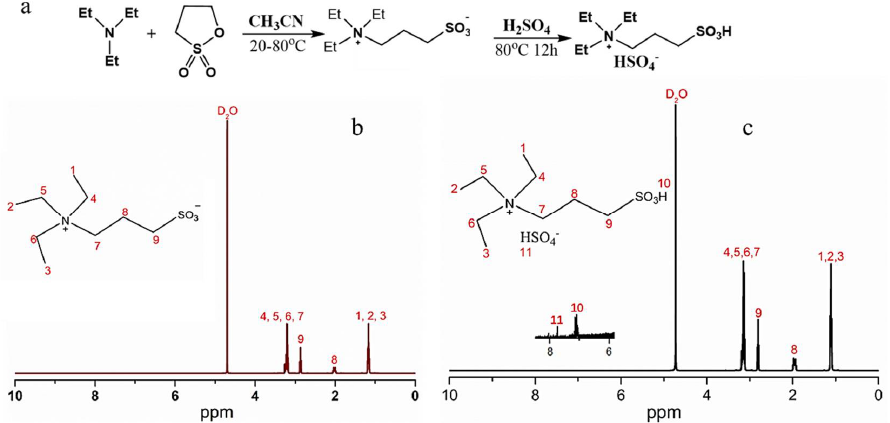
Figure 3. Synthetic route of the [TEAPS][HSO 4 ] ionic liquid ( a ), proton nuclear magnetic resonance ( 1 H NMR) spectra of the TEAPS intermediate compound ( b ), and the final product of the [TEAPS][HSO 4 ] ionic liquid ( c ).